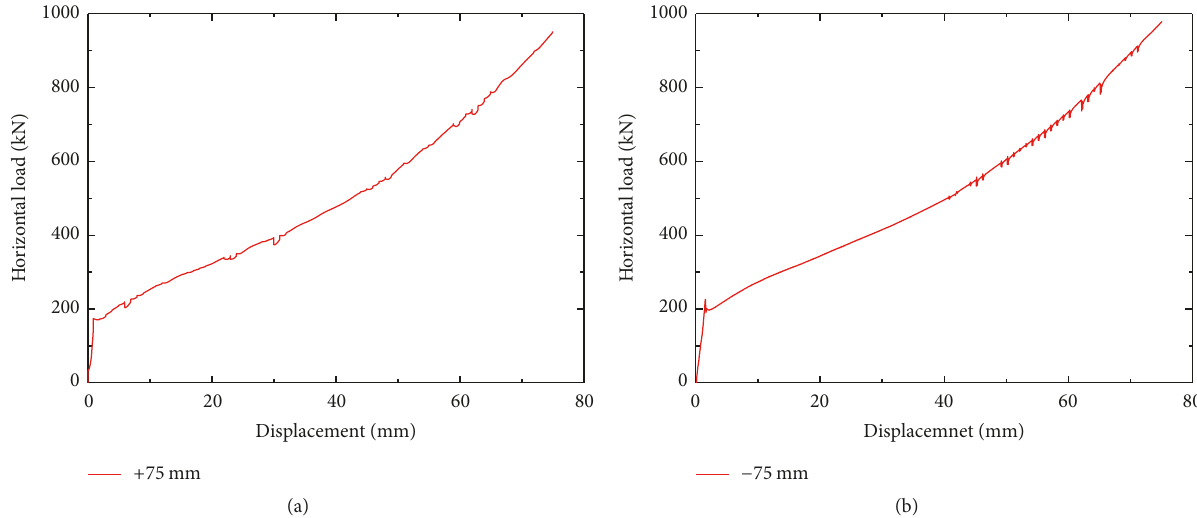
Figure 14: Test curves of ultimate shear property: (a) 75 mm and (b) − 75 mm.